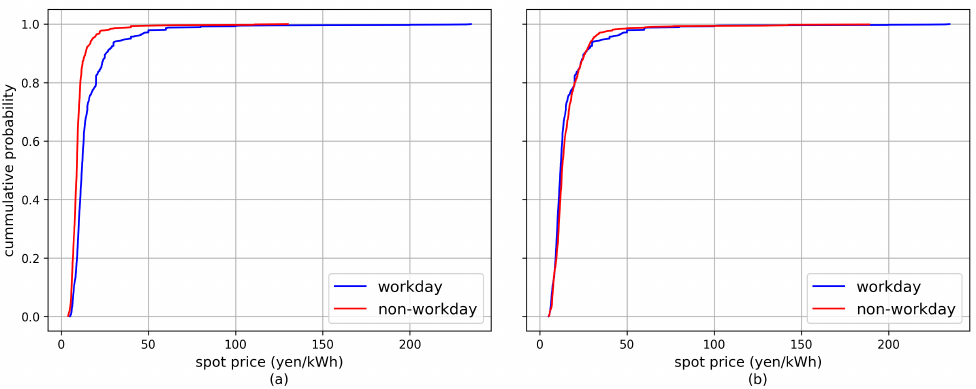
Figure 4. Empirical cumulative distribution curves (cdfs) for the Tokyo area MCPs (trading period 33: 16:00–16:30) ( a ) without the application of the transformation of Equation (1) and ( b ) with the application of the transformation of Equation